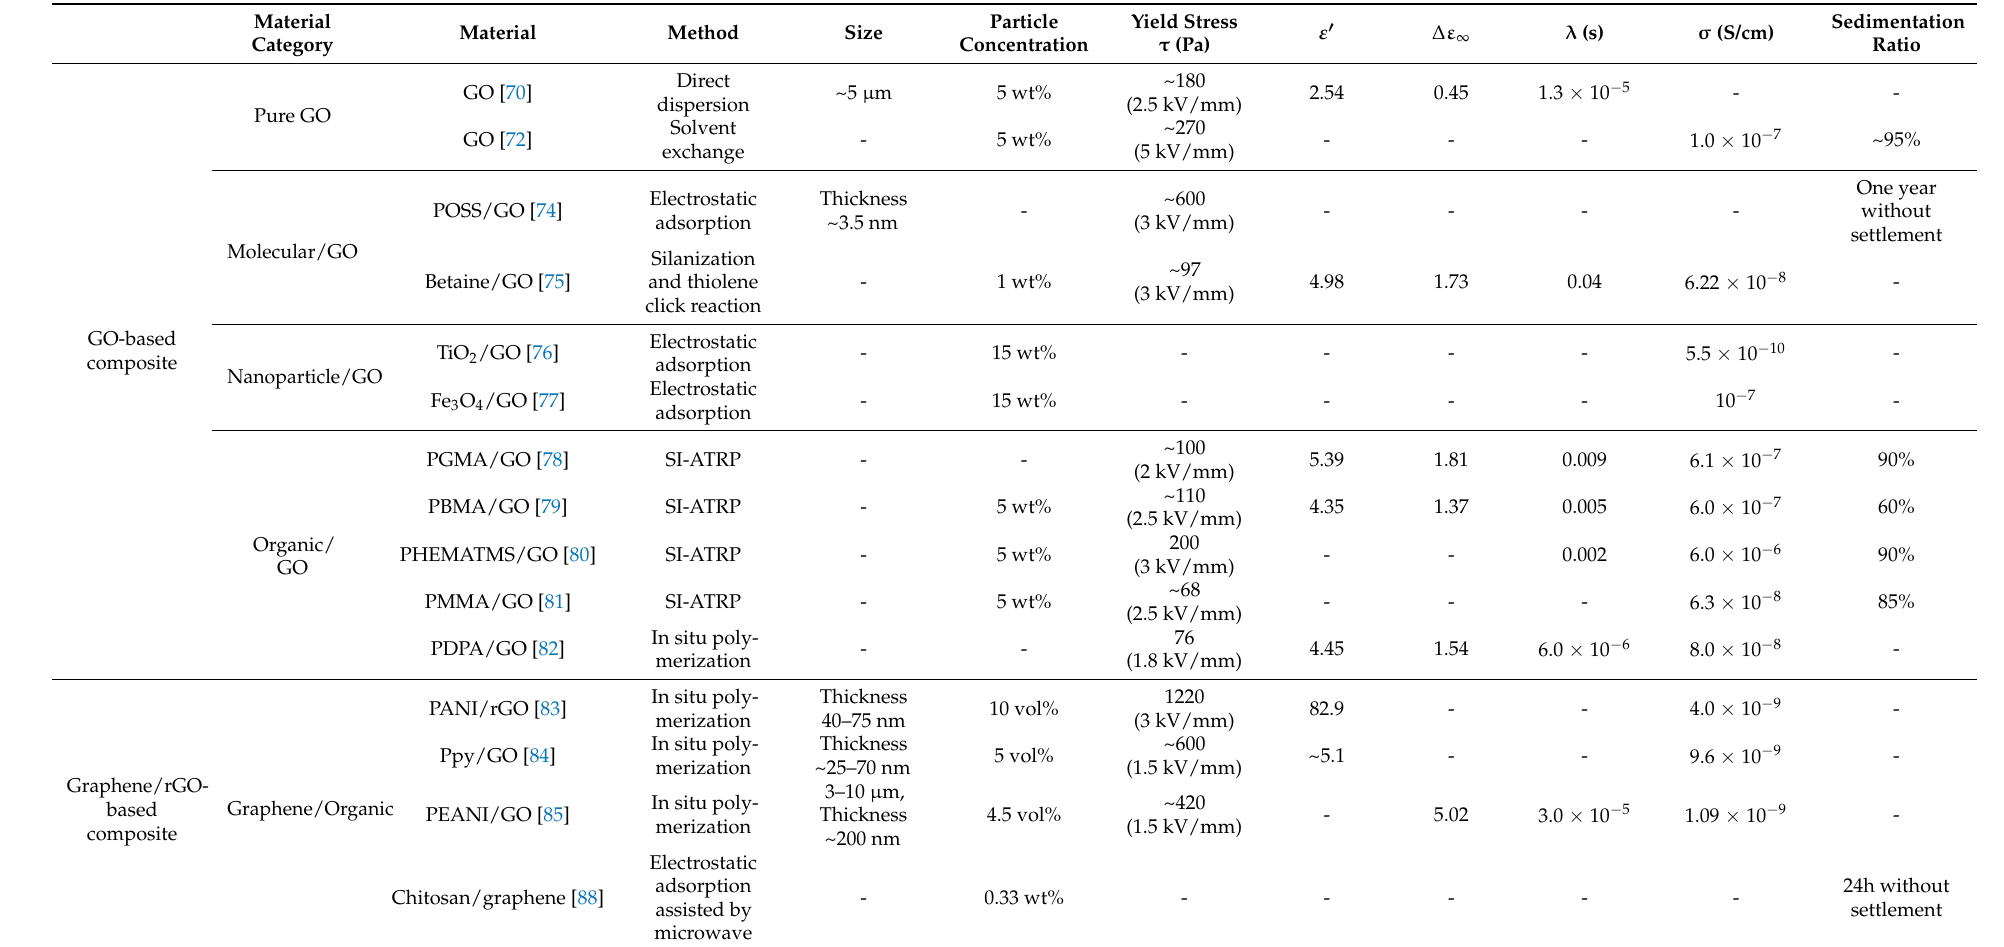
Table 1. The properties of GO/graphene-based nanoplate ER